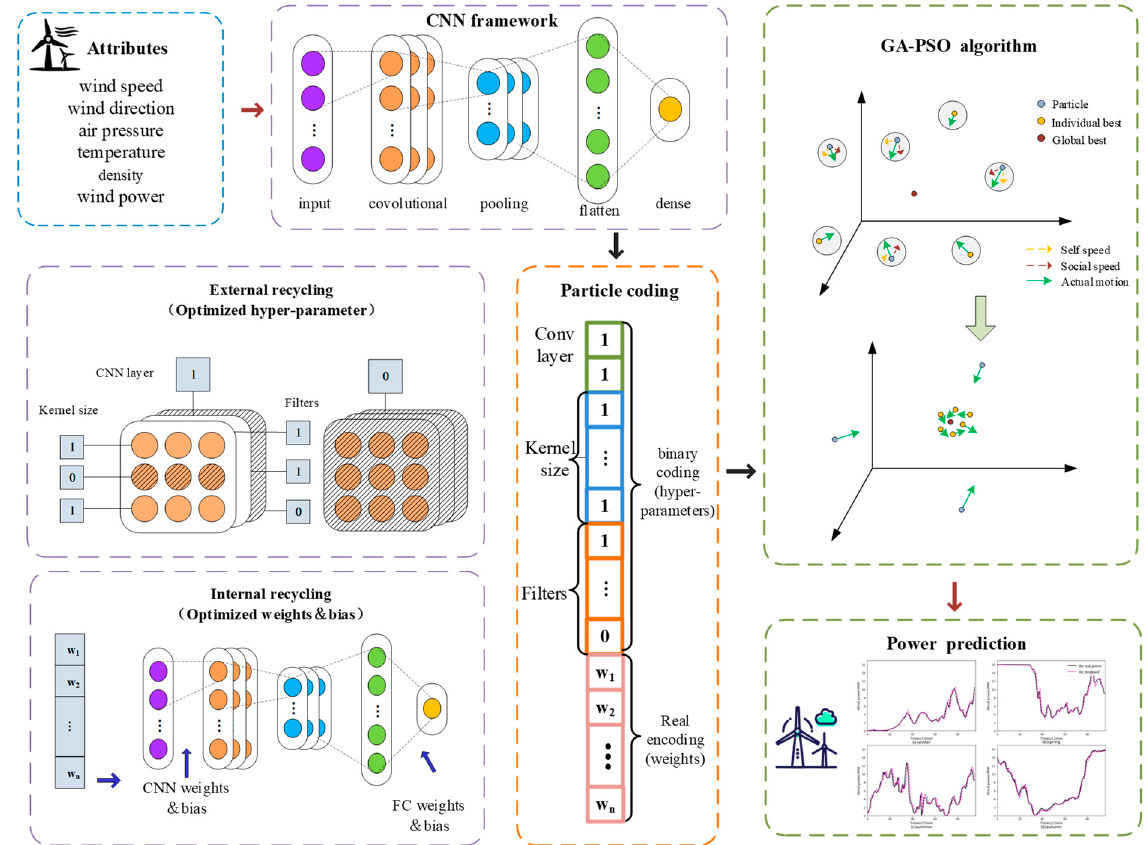
Figure 3. GA–PSO–CNN framework.